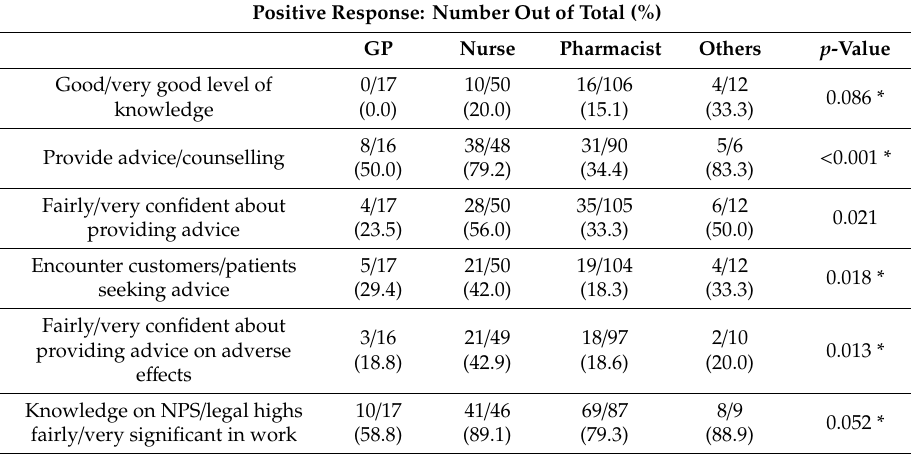
Table 2. Comparison of type of practitioner by aspects of NPS use between